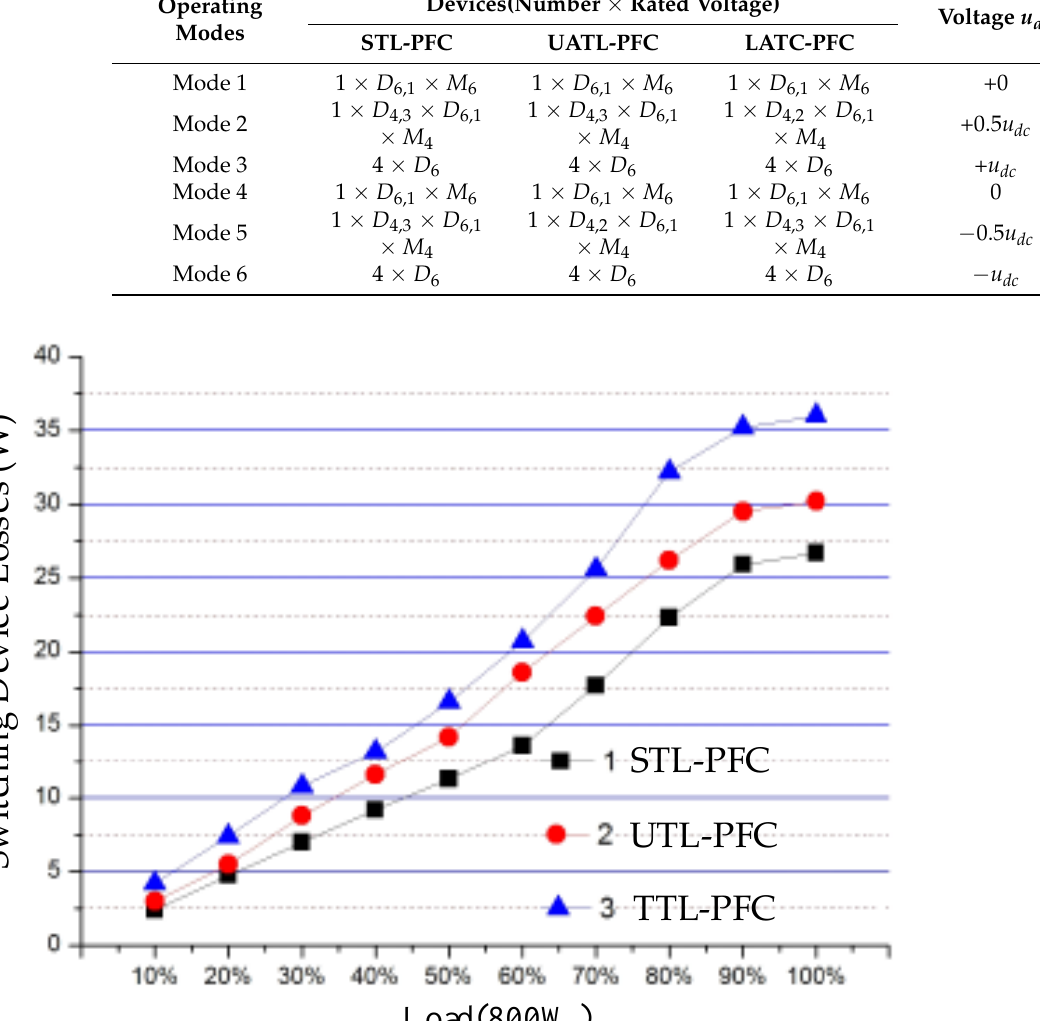
Table 3. Switching devices in conduction state under different operation modes. Operating